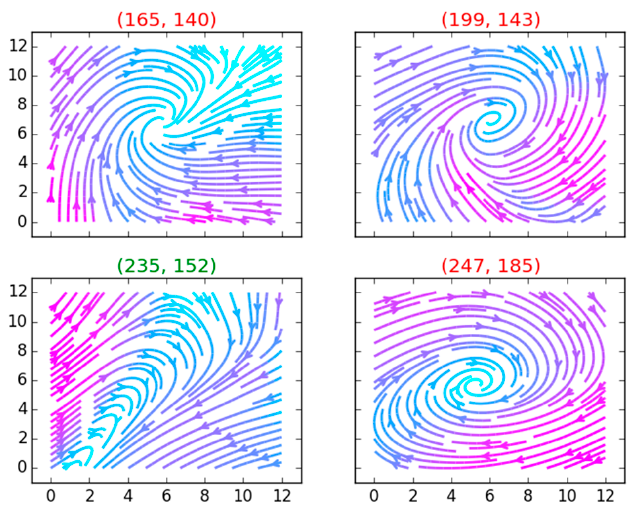
Figure 10. Comparison of the identification result with the plot figure (6 × 6 neighbor grid).